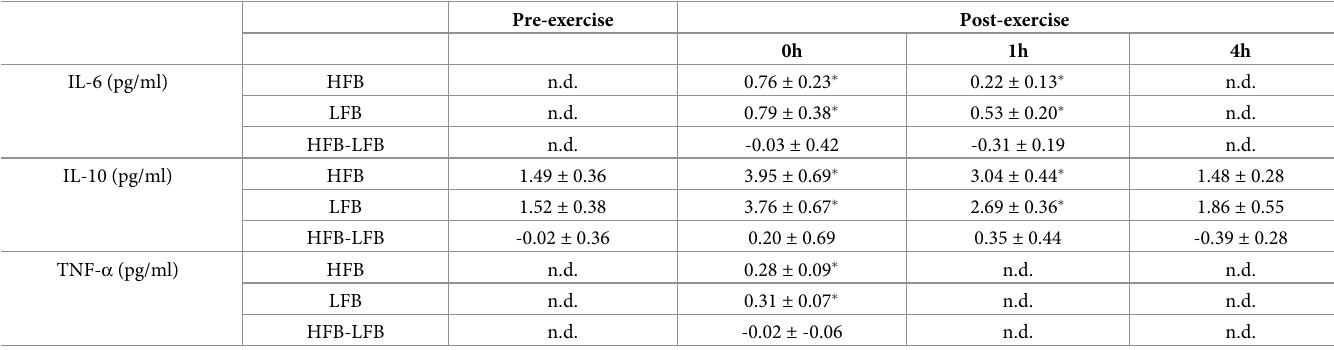
Table 2. Plasma cytokines pre-and post-exercise.